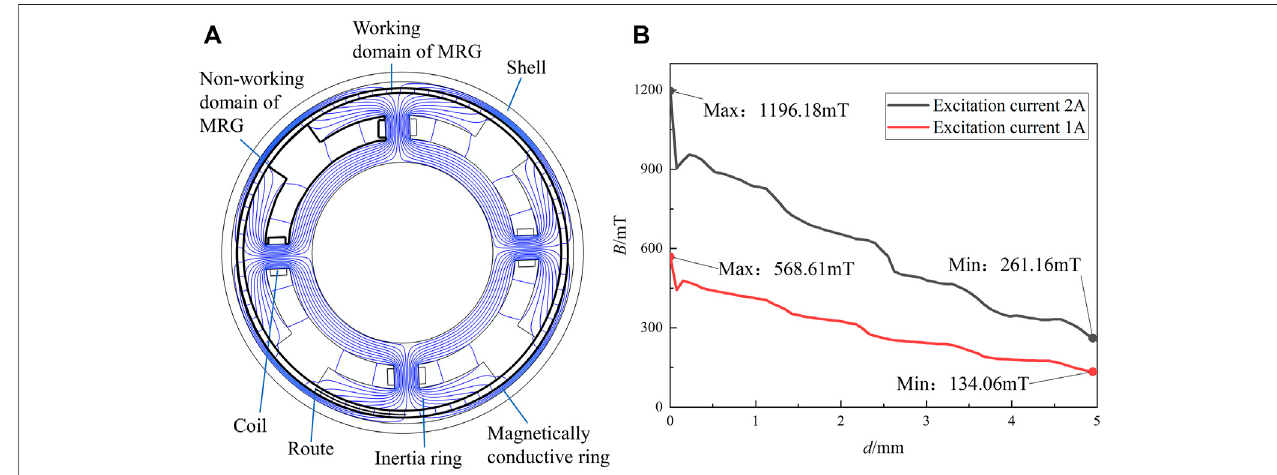
FIGURE 6 | Magnetic fi eld simulation: (A) magnetic excitation line distribution and (B) B-d curve.